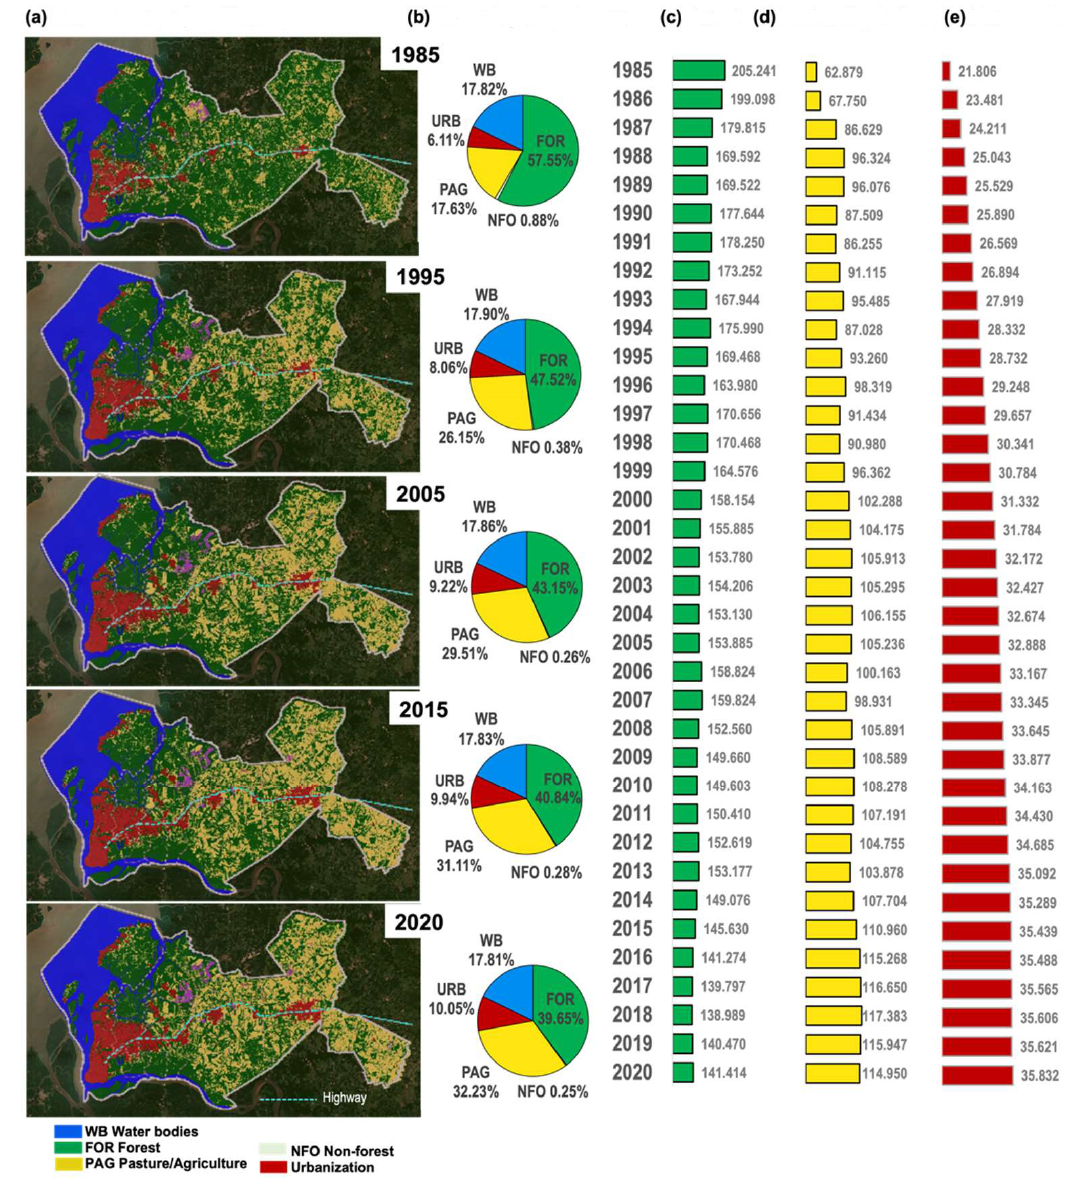
Figure 8. ( a ) Landcover maps over MRB; ( b ) percentages by classes; ( c ) forest; ( d ) pasture/agriculture; and ( e ) urbanization. Results for ( a , b ) are shown in the years 1985, 1995, 2005, 2015, and 2020. The annual series for ( c – e ) are in area (ha) from 1985 to 2020.